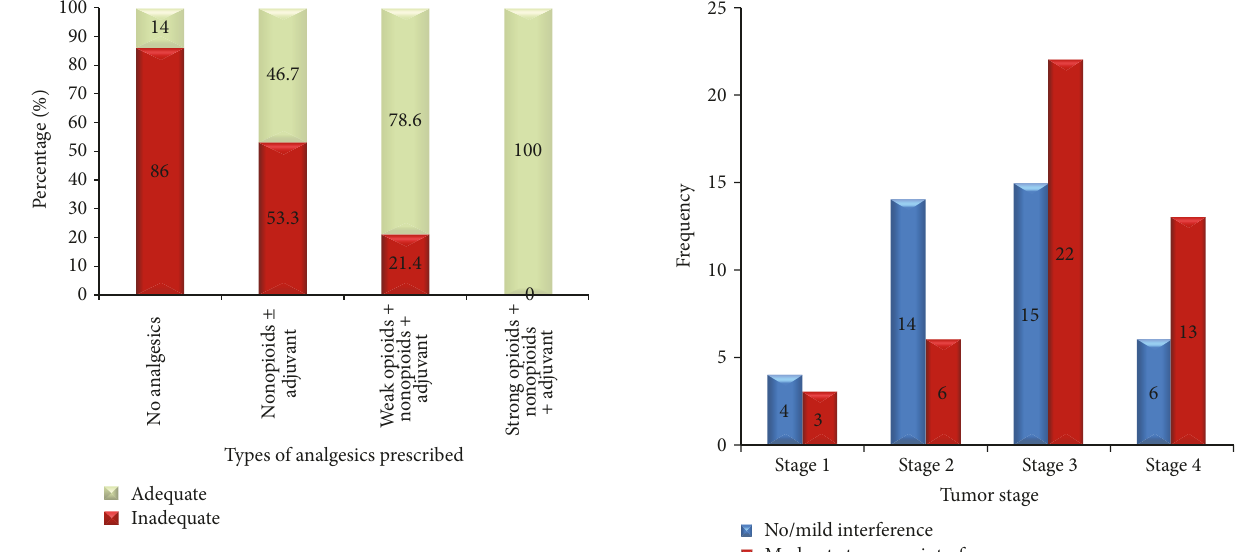
This deviation may be well explained by poor awareness